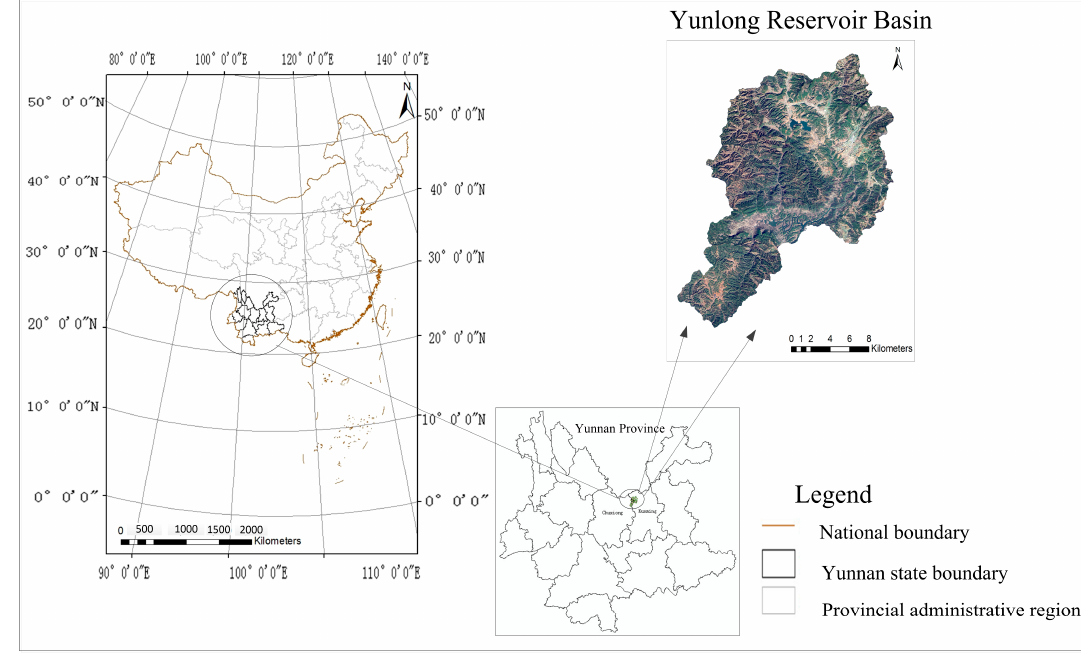
Figure 1. Location of Yunlong Reservoir Basin.